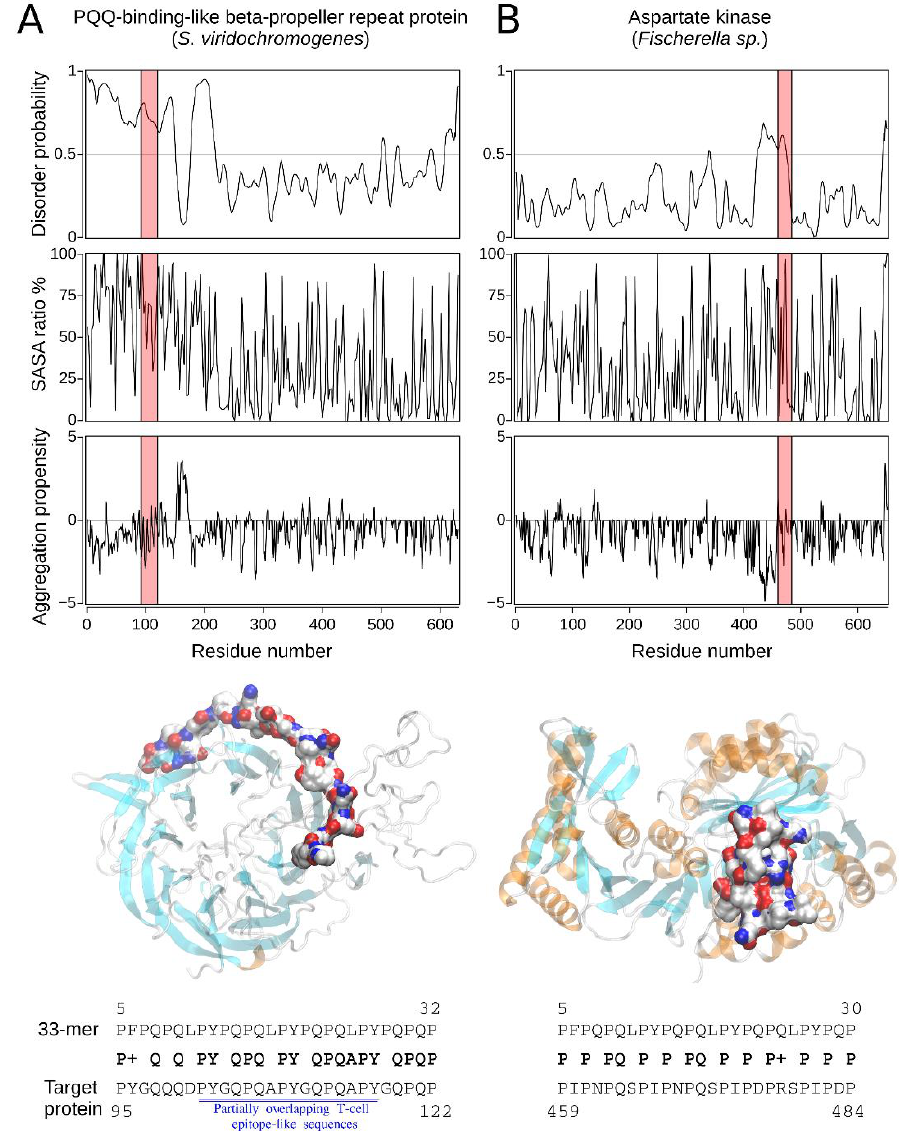
Figure 3. Sequence and structural characterization of target proteins found by BLASTp search of the 33-mer peptide . For both target proteins from Streptomyces viridochromogenes ( A ) and Fischerella sp ( B ) the region sharing high sequence similarity with the 33-mer sequence is shown in a red box. The disorder prediction (top panel) of the best hits was calculated by the PrDOS server setting a 5% threshold (false positive rate, gray horizontal line). The percentage of solvent-accessible surface area (SASA) was calculated after an energy minimization of the tridimensional models (middle panel). The structure-based aggregation propensity (lower panel) was calculated using AGGRESCAN 3D, where positive values indicate an aggregation-prone region (horizontal line). The tridimensional structure of the target proteins was modeled using the PHYRE2 server. The regions sharing high sequence similarity with the 33-mer sequence are shown in surface representation. In addition, the sequence alignments between the 33-mer sequence and the high similarity region of the target proteins are shown at the bottom. Partially overlapping copies of T-cell epitope-like sequences are blue underlined in the alignment of panel ( A ).